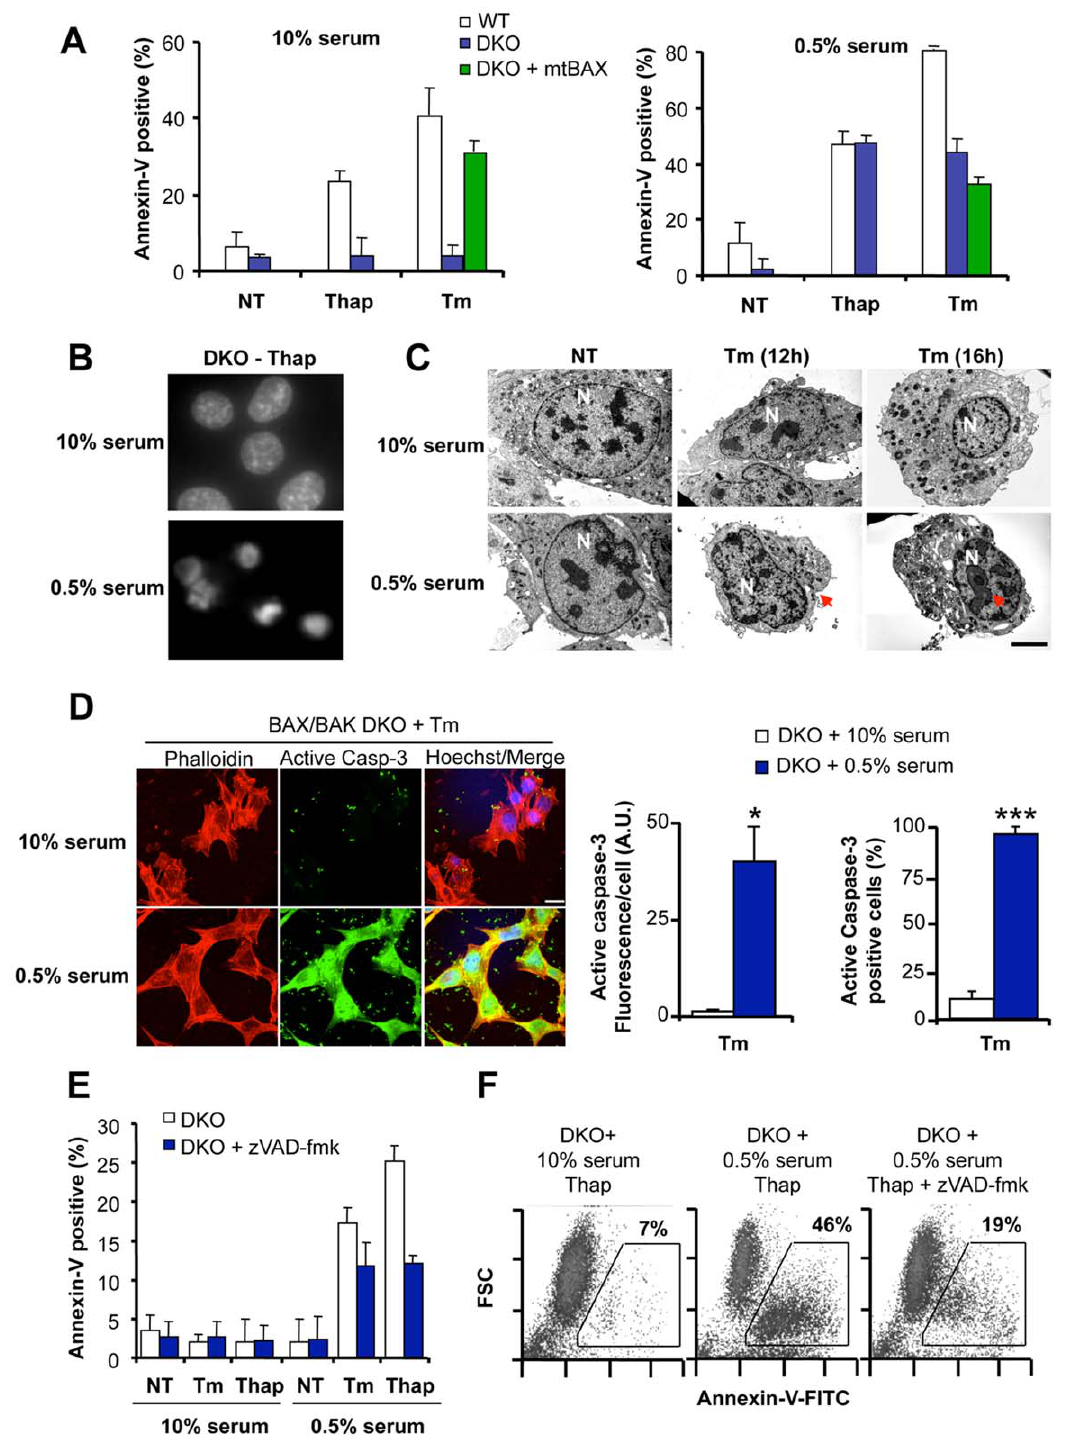
Figure 2. BAX and BAK double deficient cells undergo caspase-dependent apoptosis under conditions of ER stress in conjunction with serum withdrawal. ( A ) Left panel: WT, BAX/BAK DKO cells or DKO cells stably reconstituted with mitochondrial-targeted BAX (mtBAX) were treated with 10 m M Thap or 10 m g/ml Tm under normal growing conditions (10% serum). After 12 h, apoptosis was monitored by Annexin-V-FITC and PI staining followed by FACS analysis. Mean and standard deviations are presented of three determinations. Right panel: Alternatively, experiments were performed in cells pre-treated for 2 h with cell culture media containing 0.5% serum, followed by the addition of ER stress agents. ( B ) BAX/BAK DKO cells were exposed to 10 m M Thap in the presence of cell culture media containing 10% serum or pretreated in media containing 0.5% serum, and then cells were stained with Hoechst to visualize nuclear morphology by fluorescent microscopy. ( C ) Cell morphology was monitored in BAX/ BAK DKO cells treated with Tm for 12 h or 16 h under normal growing conditions or in cells pretreated for 2 h with media containing 0.5% serum. Untreated (NT) cells are also presented as control. Red arrowheads indicate classical apoptosis morphological features including chromatin